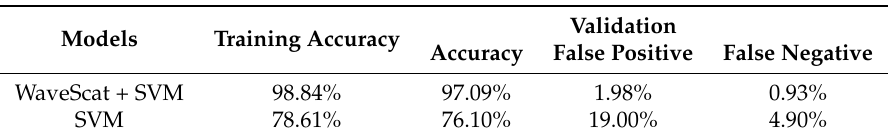
Table 6. Accuracy and confusion results of horizontal signals (considering surface roughness) with or without wavelet scattering networks in the machine learning